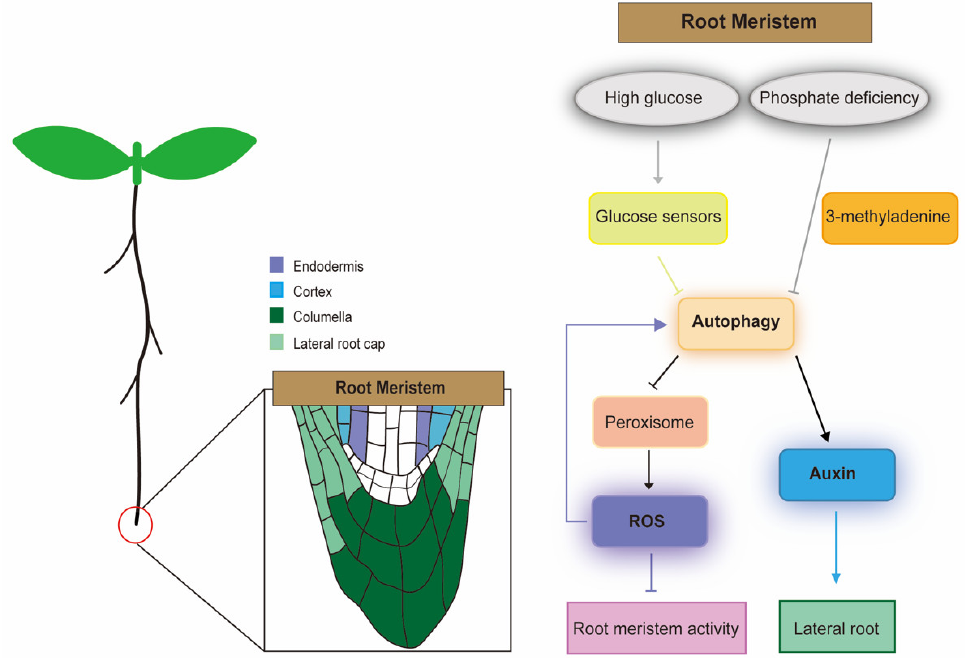
Figure 2. Schematic diagram of the regulatory network of autophagy in the Arabidopsis root meristem. Under high glucose stress, the glucose sensor signals to the autophagy system. Autophagy further regulates peroxisomes and contributes to the production of ROS. ROS accumulation under the induction of high levels of glucose impairs root meristem activity, and high levels of ROS also enhance autophagy mechanisms to maintain root meristem function under stress conditions. Under the phosphate-deficient condition, LR development and auxin accumulation in root meristems are inhibited when autophagy is inhibited by treatment with the autophagy inhibitor 3-methyladenine. Arrow indicates positive interactions; barred arrows indicate repressive interactions.